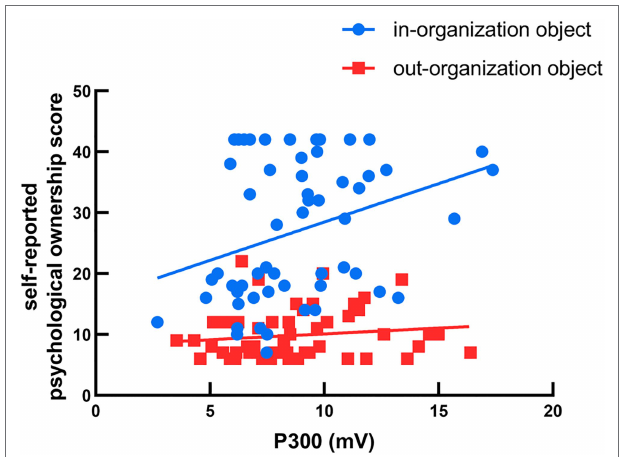
FIGURE 5 | Correlation between subjects’ self-reported psychological ownership and the amplitude of P300. Self-reported psychological ownership was calculated by scales, and the P300 was defined as the peak amplitude occurring 300–500 ms after the onset of object presentation at the electrode sites of Pz, P3, and